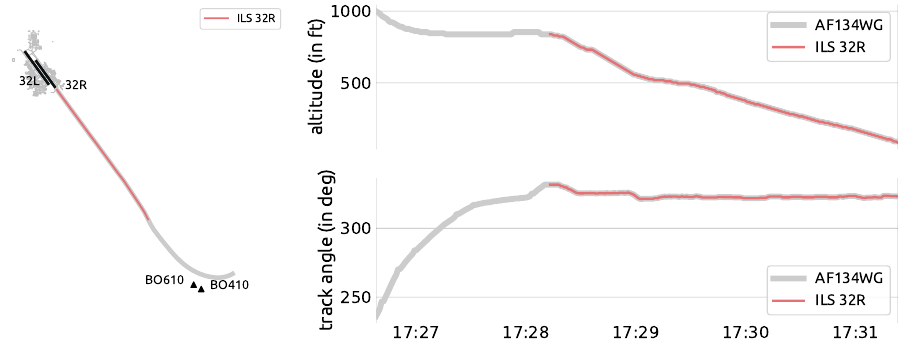
Figure 7. The rule-based method did not match situations that had similar characteristics to regular runway changes. This late runway alignment on 32R with a late catching of the glide plan after the aircraft attempted an alignment on 32L is detected by the statistical